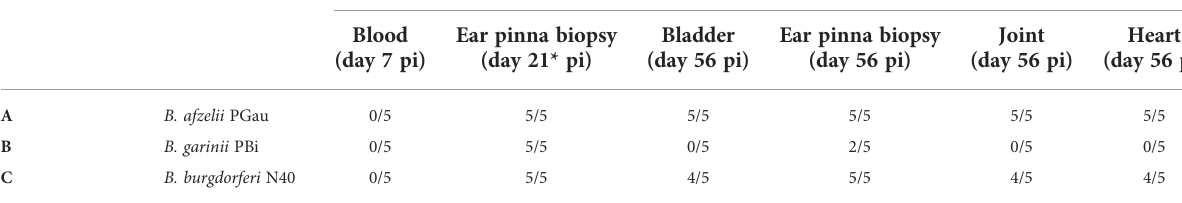
TABLE 1 Culture results of tissues harvested from Borreliella -infected C3H mice. Mouse